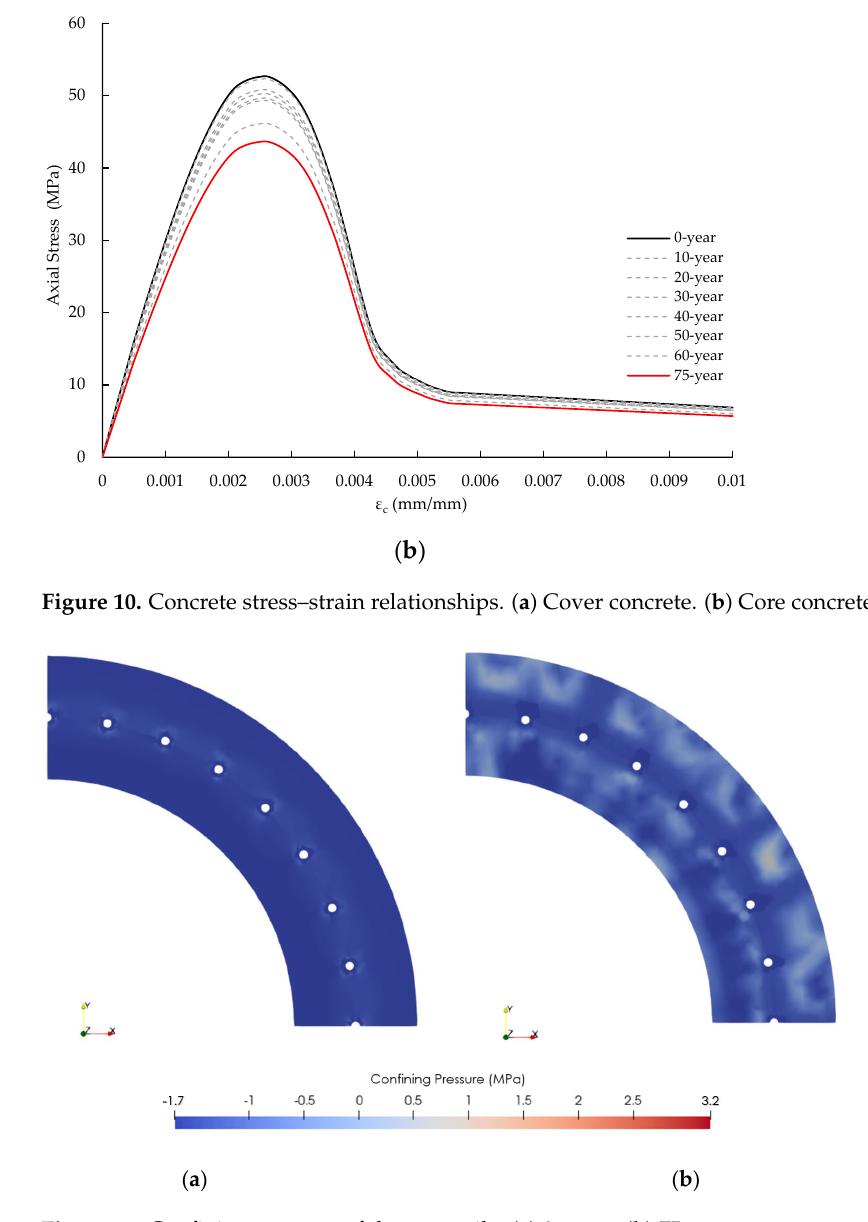
Figure 11. Confining pressure of the spun pile. ( a ) 0 years. ( b ) 75 years.